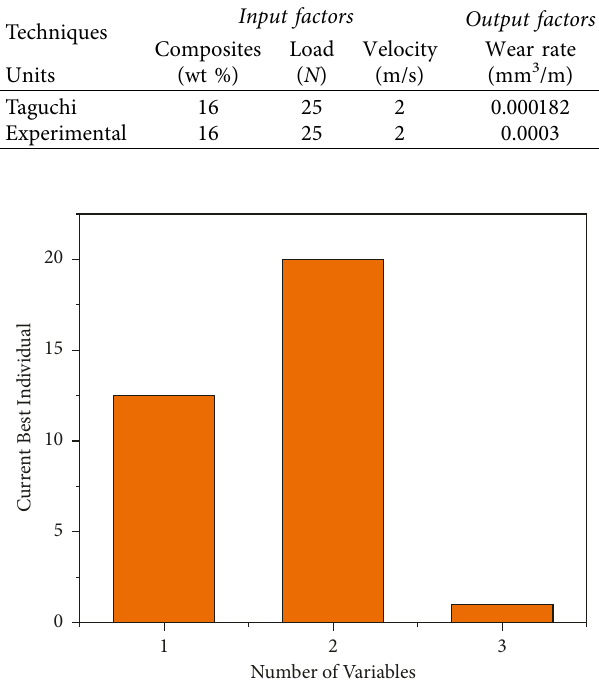
Figure 8: Minimal wear rate estimation output attained by the